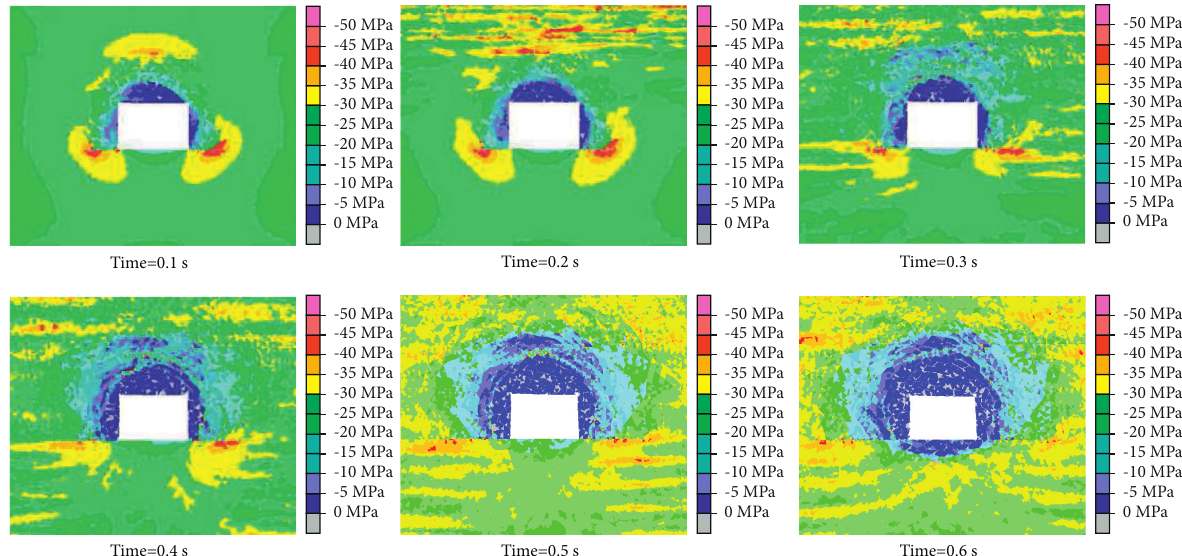
Figure 8: Evolution of maximum principal stress in the surrounding rock of